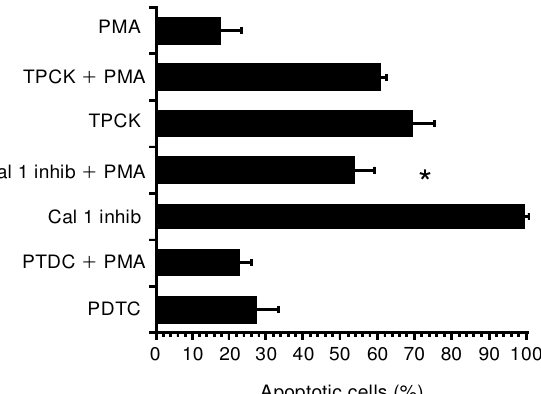
FIG. 4. Effects of PMA on apoptosis induced by NF- k B inhibitors. RAW 264.7 cells were incubated for 18 h with either PMA (10 nM), PDTC (100 m M), TPCK (50 m M), calpain I inhibitor (10 m M) or PMA with PDTC, TPCK with PMA or calpain I inhibitor with PMA. The mean percentage of cells undergoing apoptosis as assessed by acridine orange staining is represented on the abscissa. Error bars represent SEM. , signi® cant reduction in apoptosis in cells treated with a combination of calpain I inhibitor and PMA com- pared to cells treated with calpain I inhibitor alone (P , 0 · 05). Each experiment was repeated at least three times.